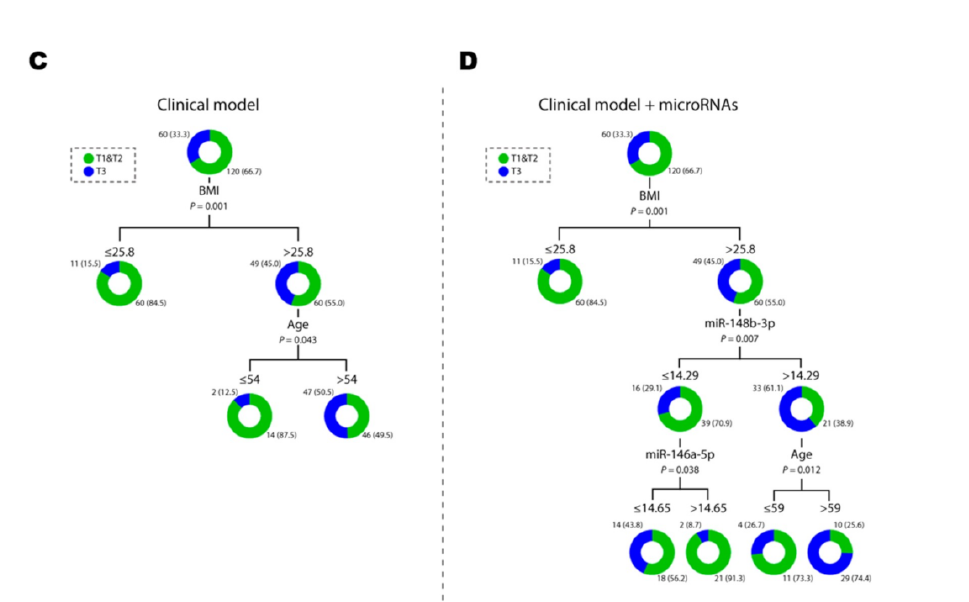
Figure 3. Plasma microRNAs (miRNAs) as biomarkers of epicardial fat volume, according to EFV tertiles. ( A ) Area under the ROC curve (AUC) for each individual miRNAs and for combinations of miRNAs in pairs or families. ( B ) Performance of plasma miRNAs as biomarkers. ( C , D ) Decision trees calculated by chi-squared automatic interaction detector (CHAID) algorithm. The following variables were included in the clinical model: age, sex, body mass index and diabetes mellitus. MicroRNA levels were log 2 -transformed. For logistic regression models, data are presented as an odds ratio (OR) and 95% confidence intervals (CI). For discrimination analysis, data are presented as the AUC and 95% CI. For reclassification analysis, data are presented as the Integrated Discrimination Improvement (IDI) index and Net Reclassification Improvement (NRI) index and their respective and 95% CI. For decision trees, data are shown as frequency (percentage) of patients in each study